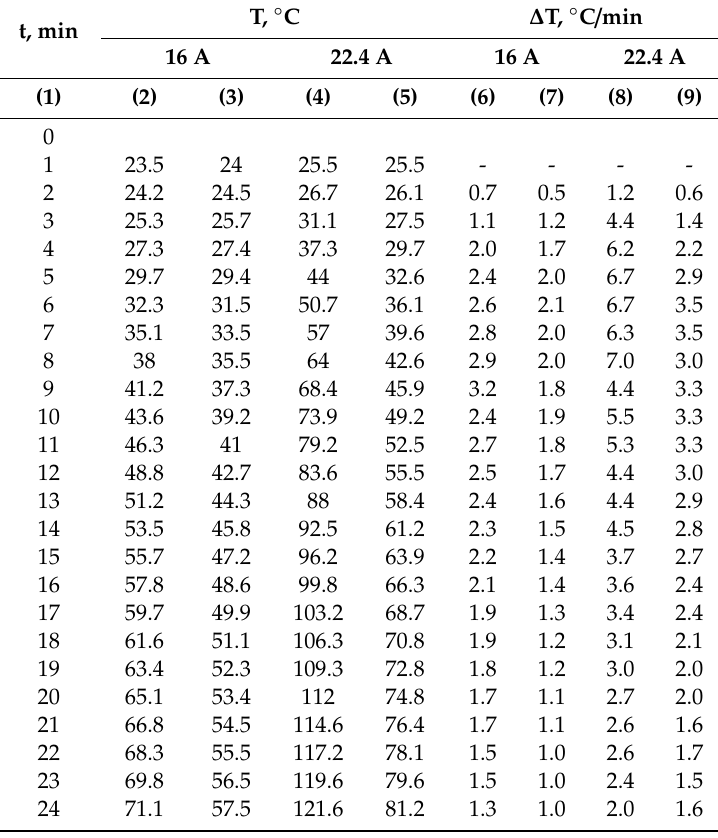
Table 3. Temperature measurements T ( ◦ C): columns (2), (4) under uncovered surface socket (measuring point 1, (3), (5) under covered surface-mounted socket (measuring point 2), with the load circuit current 16 A or 22.4, A respectively. Relevant increase of temperature is shown in columns (6), (8) and (7), (9).